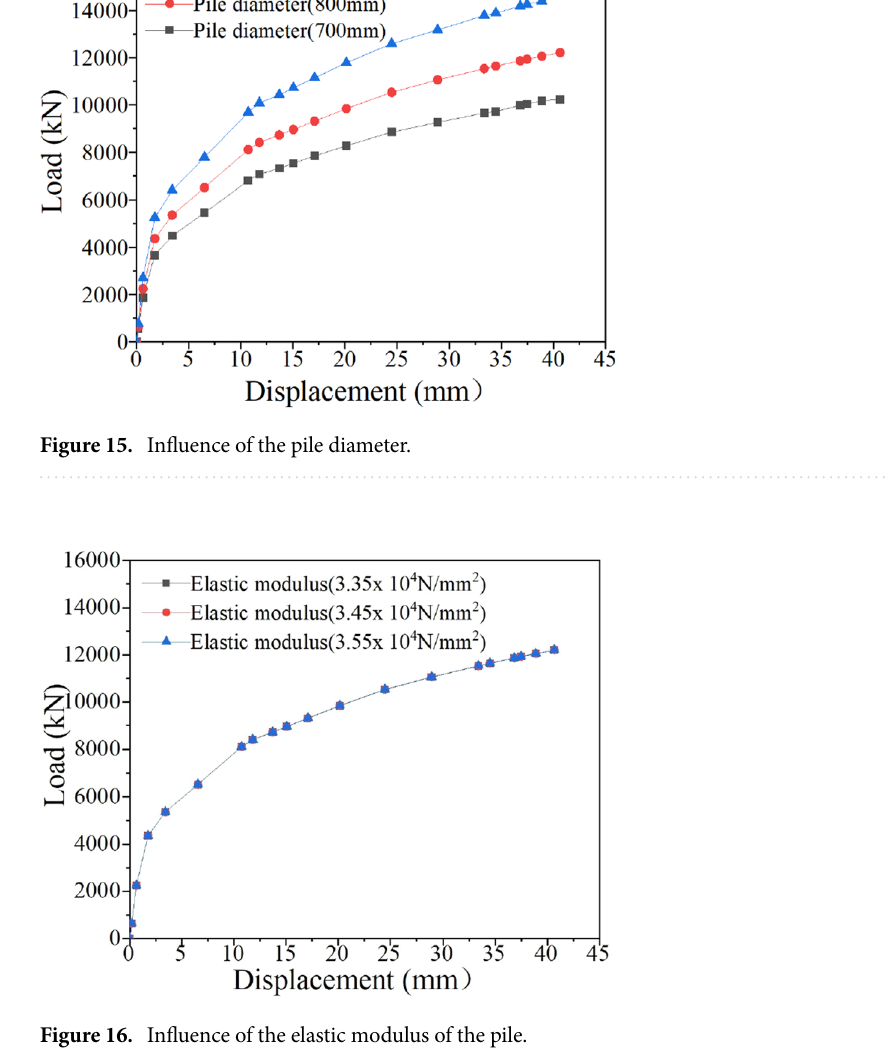
Figure 16. Influence of the elastic modulus of the